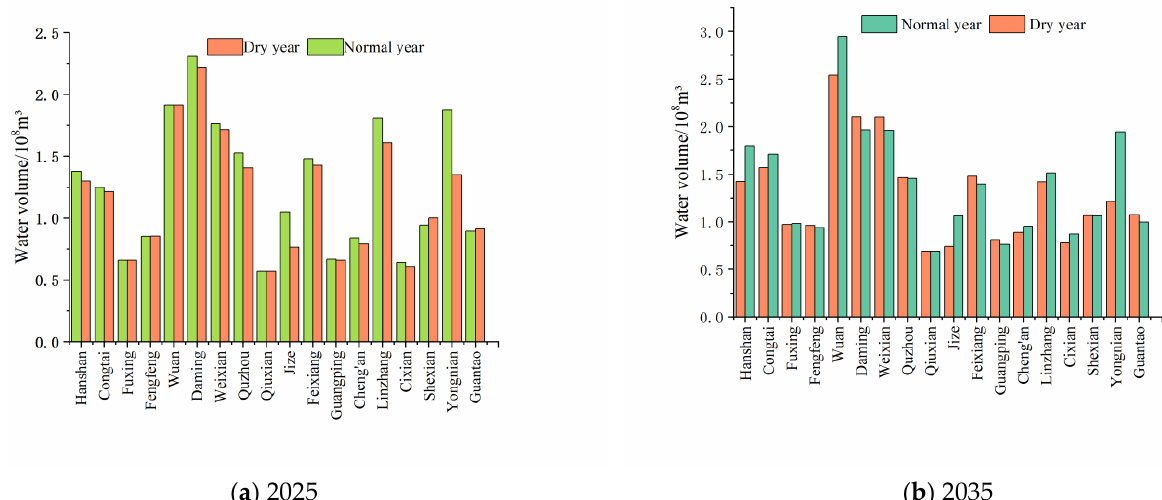
Figure 8. Allocated water volume.